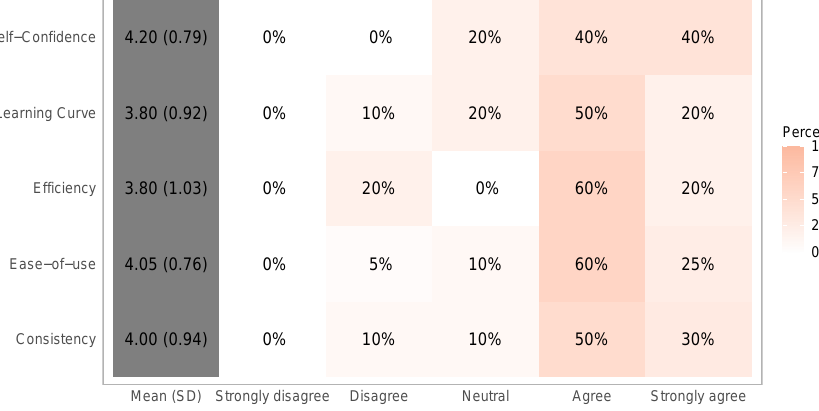
Figure 7. Results showing usability agreement by dimension for Use Case